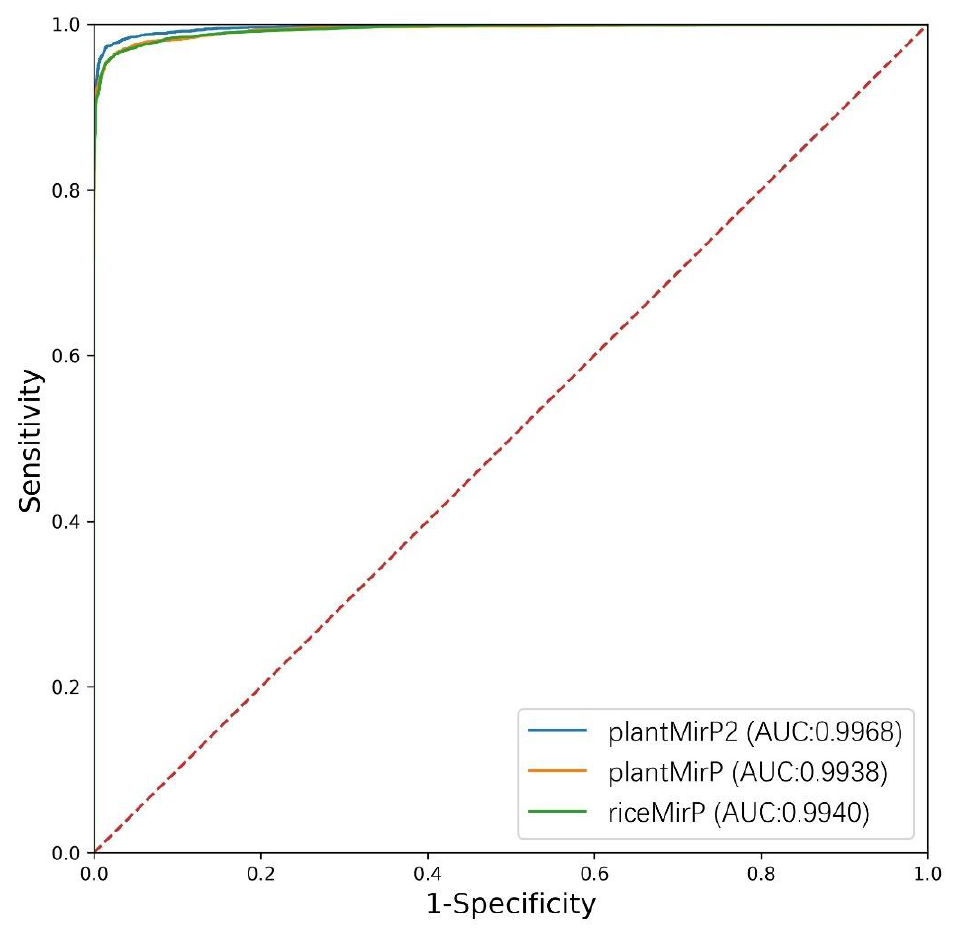
Figure 5. Based on the same training dataset and testing dataset, indicators of plantMirP, riceMirP and plantMirP2 were compared.